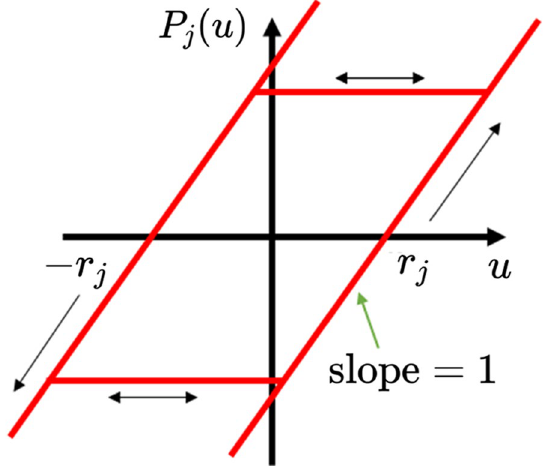
Fig. 5 Play Operator P j ( u )